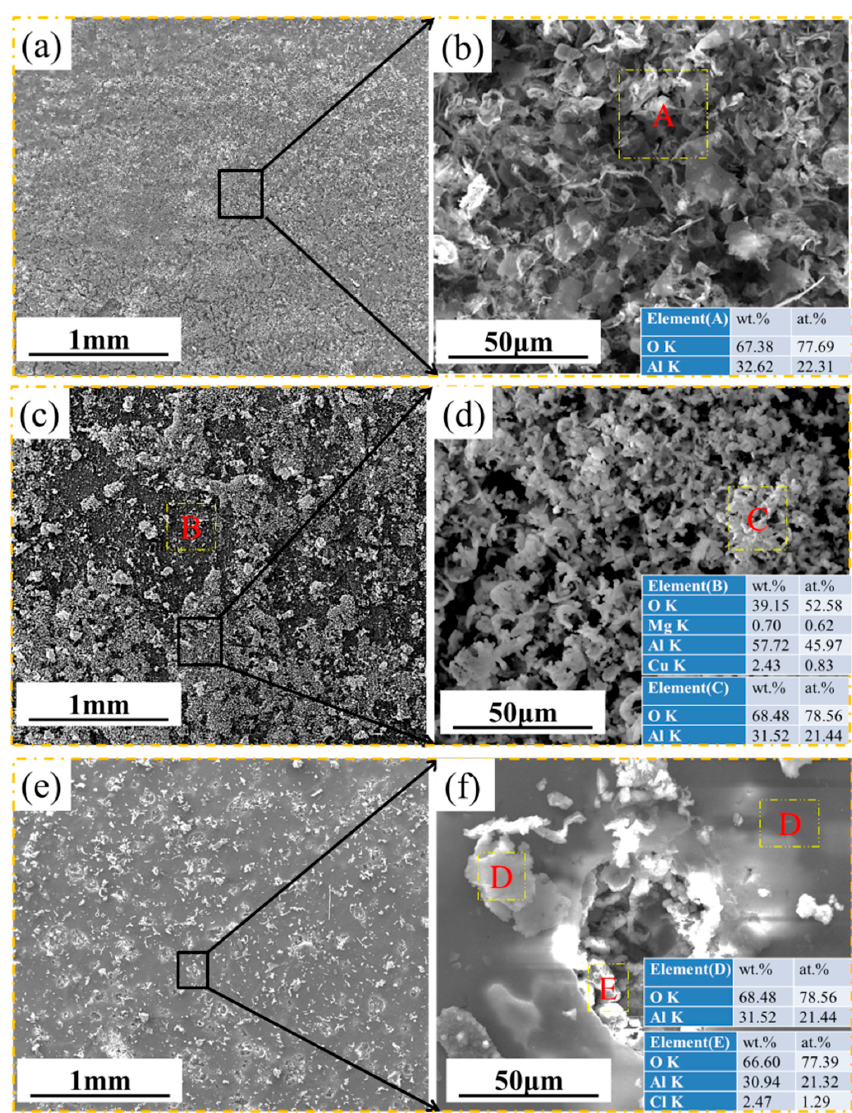
Figure 4. SEM images of microscopic surface morphology of the samples after corrosion 72 h under 4 ± 0.2 mg/cm 2 solid NaCl deposit in 98 ± 2% humidity: ( a , b ) at 30 °C; ( c , d ) at 60 °C; and ( e , f ) at 80 °C. EDS results for A-E locations were also